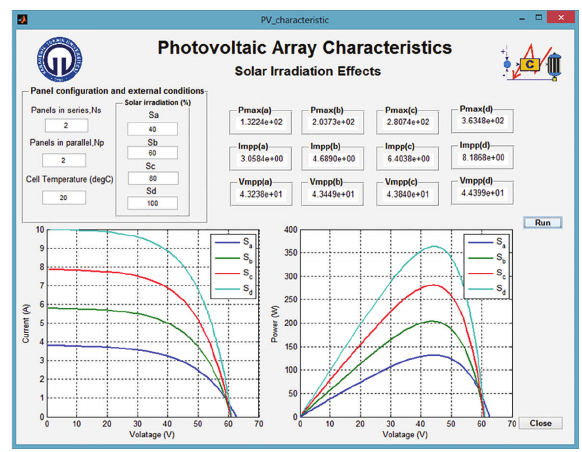
Figure 2: The photovoltaic array characteristics interface. Figure 3: The photovoltaic array solar irradiation